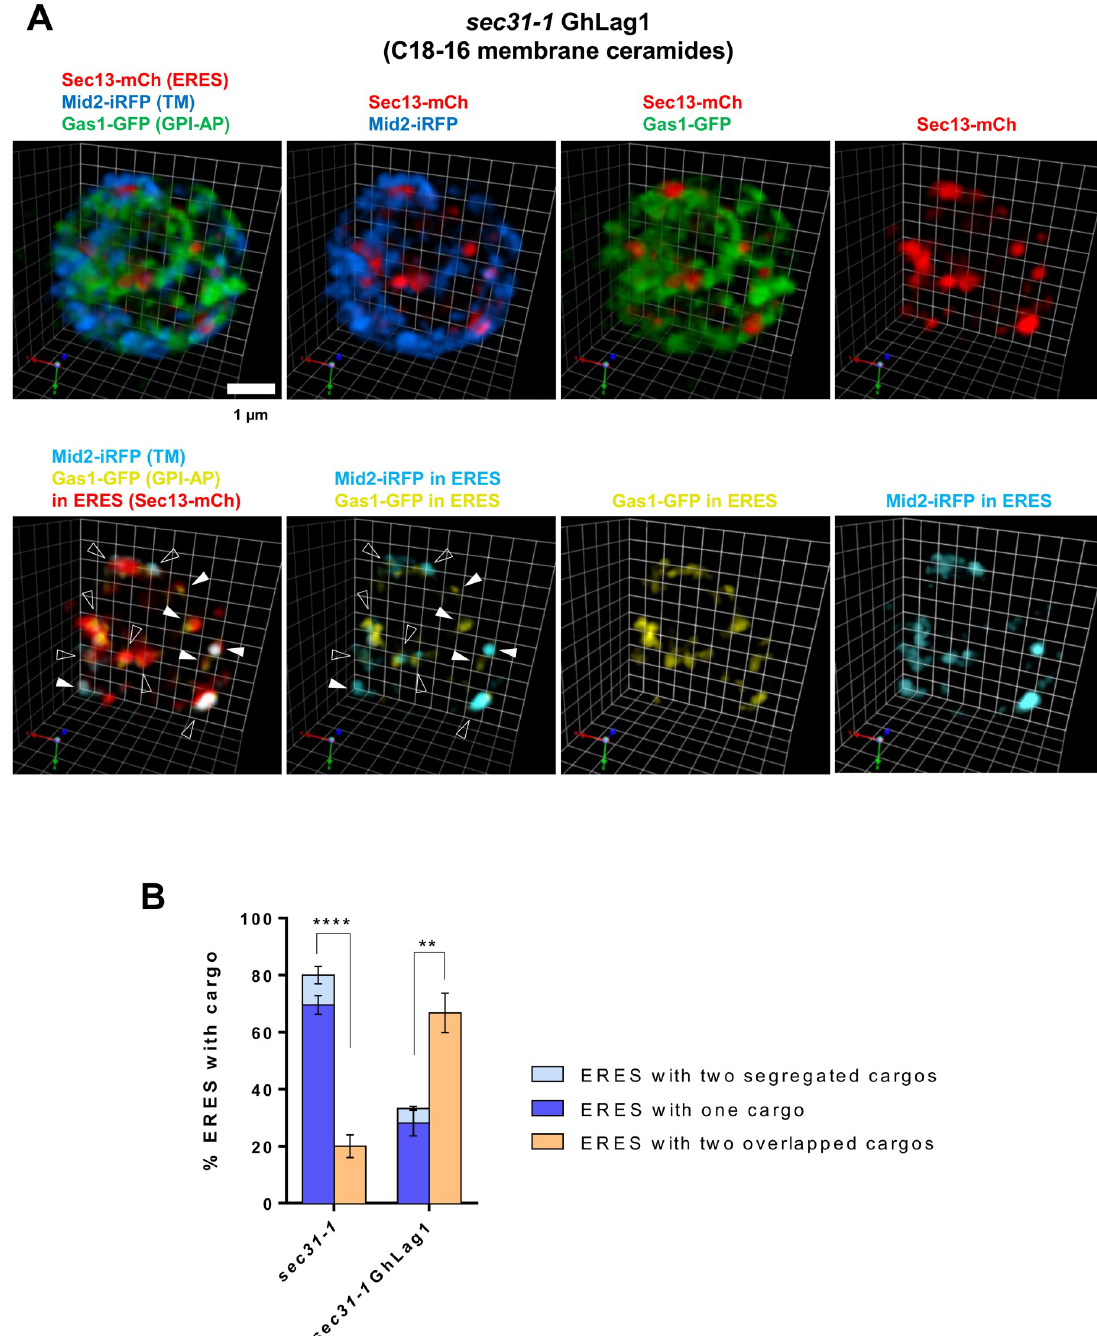
Fig 3. 3D SCLIM visualization of the synchronized incorporation of GPI-anchored and transmembrane cargos into the same ERES in sec31-1 GhLag1 cells. sec31-1 GhLag1 temperature-sensitive mutant cells co-expressing galactose-inducible secretory cargos, the GPI-AP Gas1-GFP (green) and the transmembrane (TM) protein Mid2-iRFP (blue), and the constitutive ERES marker Sec13-mCherry (red) were incubated at 37˚C for 30 min and then shifted down to 24˚C for releasing secretion block and imaged by SCLIM after 20 min with 4 fps as acquisition speed for a single XY 3 color image. 31 Z slices were obtained to acquire a 3D image of 80% of a single yeast cell in 7.75 s. (A) Representative merged or individual 3D cell hemisphere images of cargo and ERES markers. Lower panels show processed images to display only the cargo (Gas1-GFP, yellow, and Mid2-iRFP, light blue) present in the ERES (red). White filled arrowheads: ERES containing only one cargo. Open arrowheads: ERES with overlapping cargo. Scale bar, 1 μ m. Scale unit, 0.438 μ m (B) Quantification of micrographs described in Figs 2A and 3A. Average percentage of ERES containing only one cargo (Gas1-GFP or Mid2-iRFP), segregated